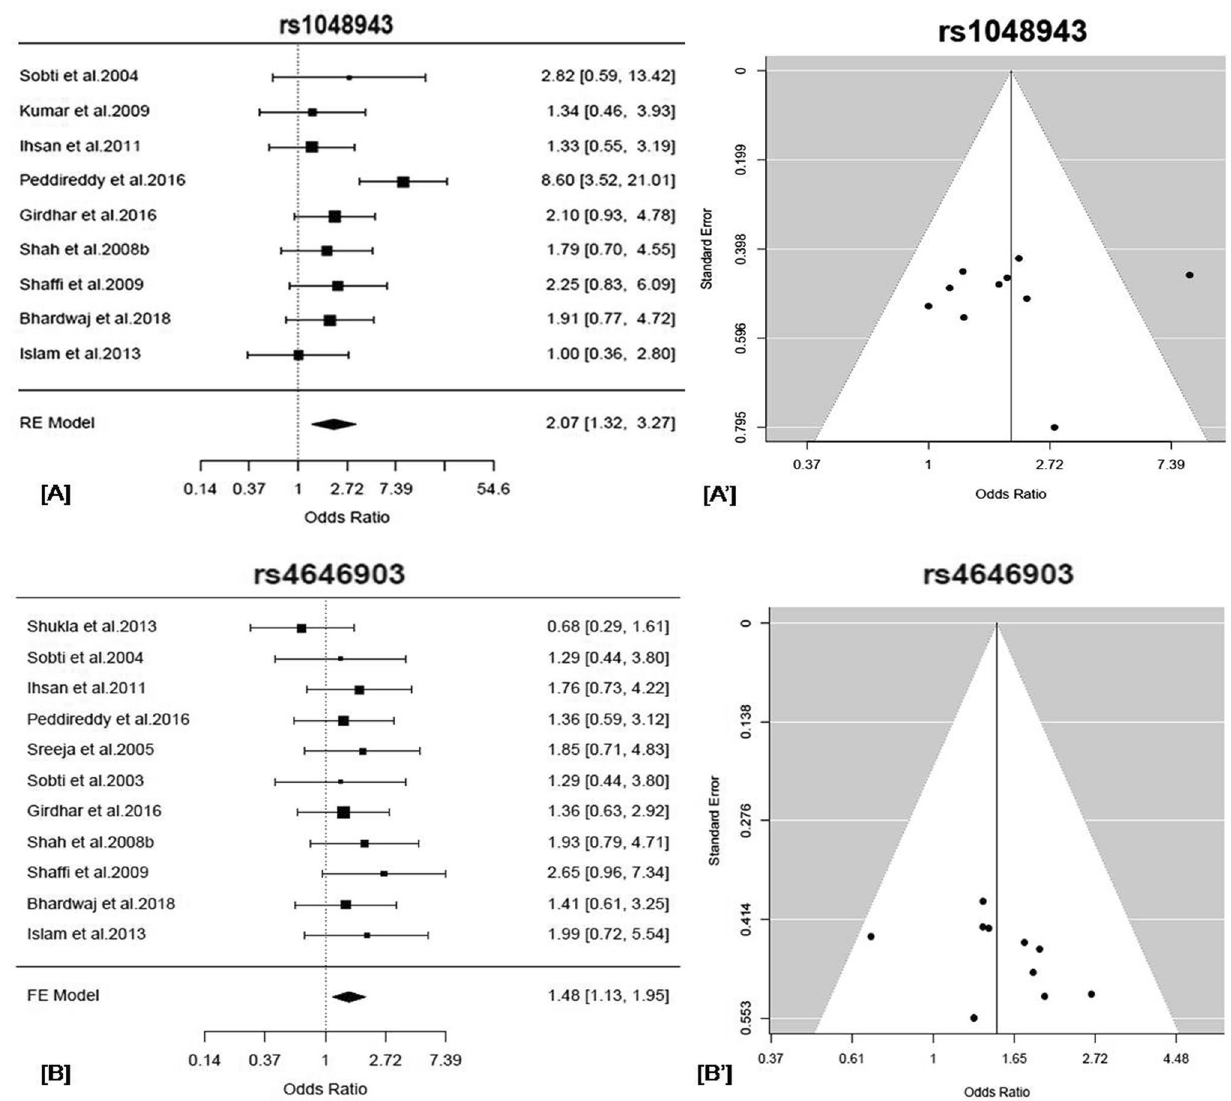
Figure 1. ( A ) Forest plot depicting the odds ratios (ORs), and 95% CI of the polymorphism, rs1048943/ CYP1A1 for its association with overall lung cancer risk in the Indian subcontinent in the random- effects model, ( A’ ) Funnel plot that shows no evidence of publication bias between the studies reporting the polymorphism, rs1048943/ CYP1A1 . ( B ) Forest plot depicting the odds ratios (ORs) and 95% CI of the polymorphism, rs4646903/ CYP1A1, is associated with overall lung cancer risk in the Indian subcontinent in a fixed-effect model. ( B’ ) Funnel plot shows no evidence of publication bias between the studies reporting the polymorphism, rs4646903/ CYP1A1 . The results are obtained in a dominant model of analysis. The forest plots of the significant associations were given ( p < 0.05*). The figures were generated in the ‘metafor’ package (http:// www. metaf or- proje ct. org) of R software (https:// cran.r- proje ct.